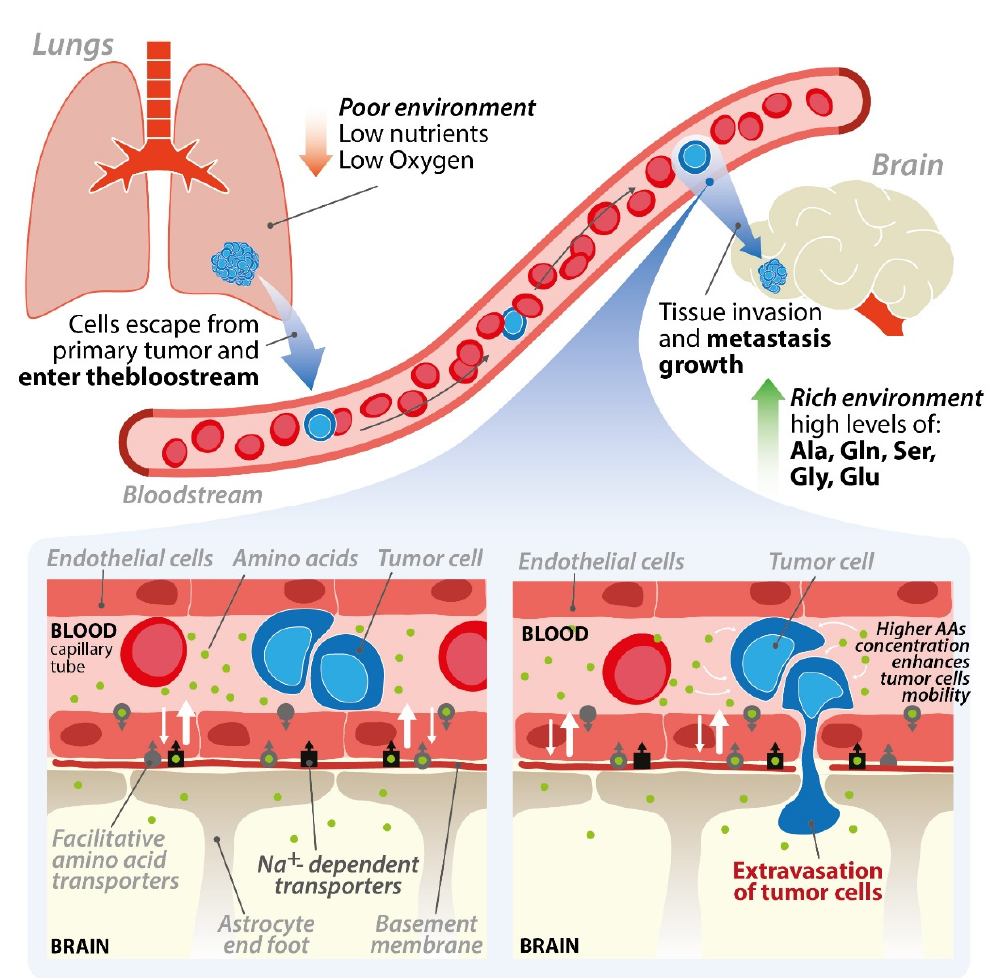
Figure 3. Hypothetical involvement of the brain to blood efflux in the metastatic process (schematic representation) (mod- ified from [63]). An increased number of amino acids in the brain microvasculature stimulate the chemo-kinetic ability of representation) (modified from [63]). An increased number of amino acids in the brain mi- metastatic cancer cells triggering the brain parenchyma invasion. crovasculature stimulate the chemo-kinetic ability of metastatic cancer cells triggering the brain parenchyma